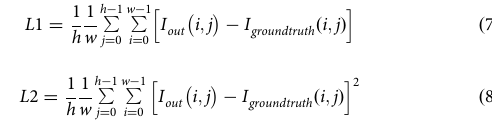
Supplementary Table 2. In the training phase, the generator is trained to recon- struct the desired output, B-scan averaged-optimal OCT image, by receiving the degraded OCT B-scan. The reconstructed B-scan is then fed to the discriminator to learn to discriminate the generated B-scan with a single output of 0 and 1, and then the feedback is returned to the generator. To train NetB, the loss functions are separately de fi ned for generator and discriminator. Because the generators